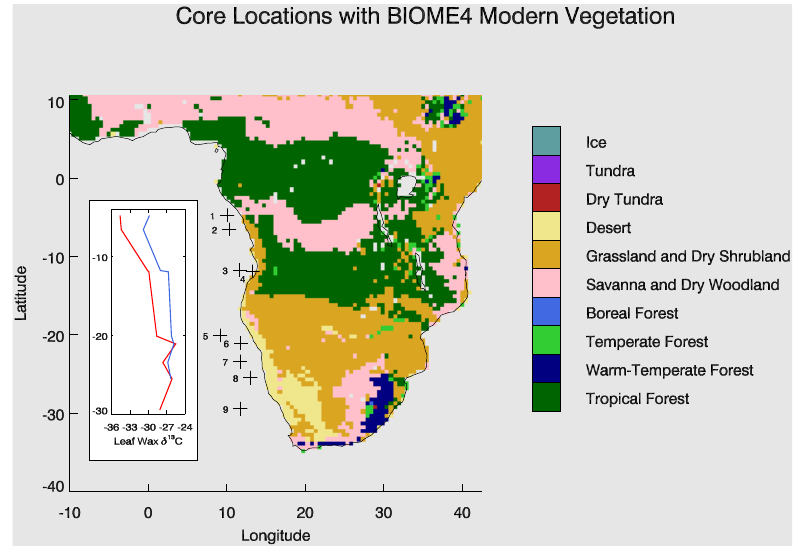
Fig. 1. Locations of the marine core sites, and the δ 13 C data of leaf-wax n -alkanes extracted from Holocene (red) and LGM (blue) sediments as a function of latitude. Data from Rommerskirchen et al. (2003, 2006). Vegetation as modelled by